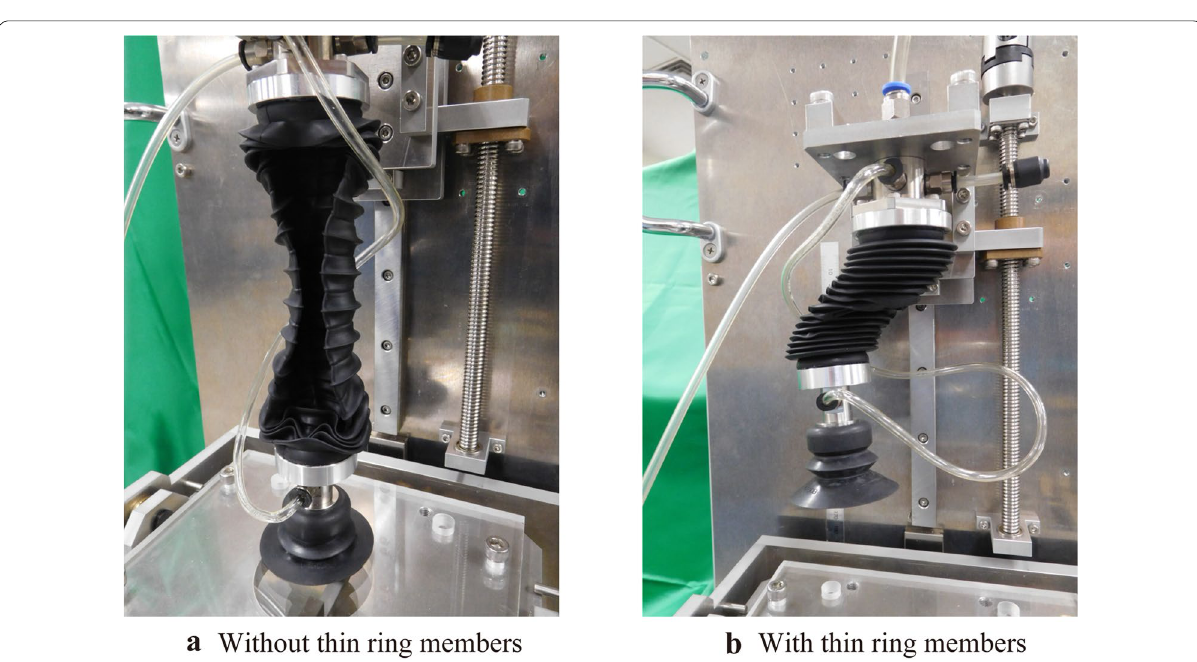
Fig. 38 Experimental view of the contractile force evaluation. a Without thin ring members, b with thin ring